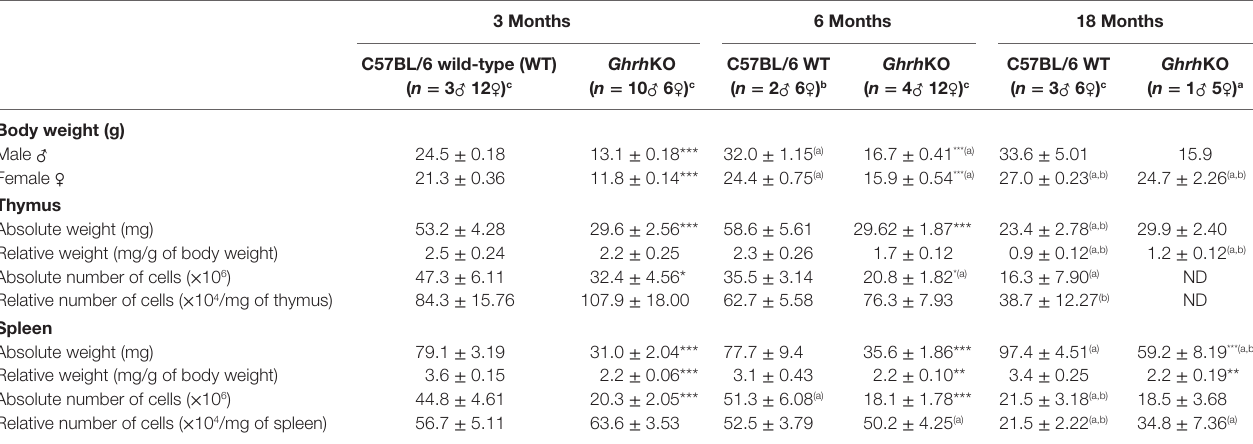
TaBle 2 | Effects of somatotrope deficiency on weight and number of cells of lymphoid